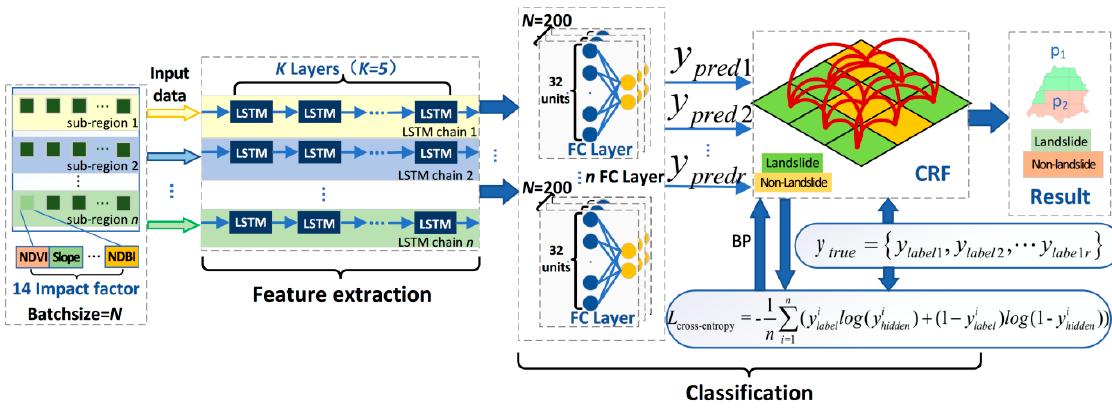
Figure 2. Algorithm flowchart. BP: Back propagation, CRF: Conditional random field, FC: Full connection, LSTM: Long short-term memory.